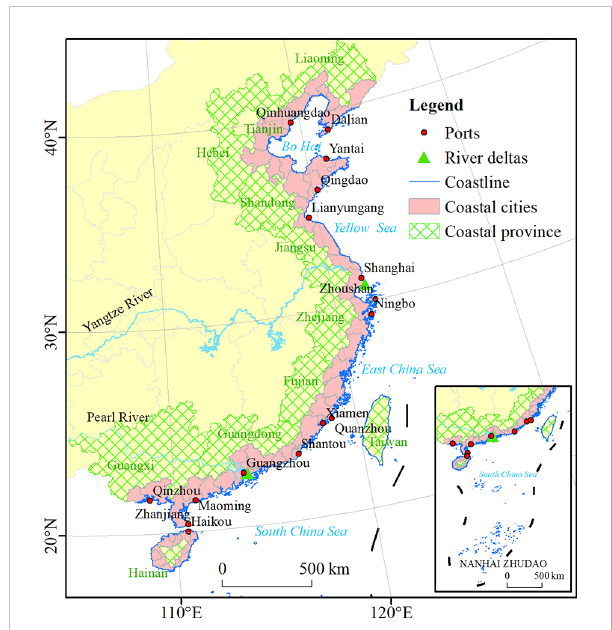
FIGURE 1 Location of coastal cities and their administrative divisions, ports, and